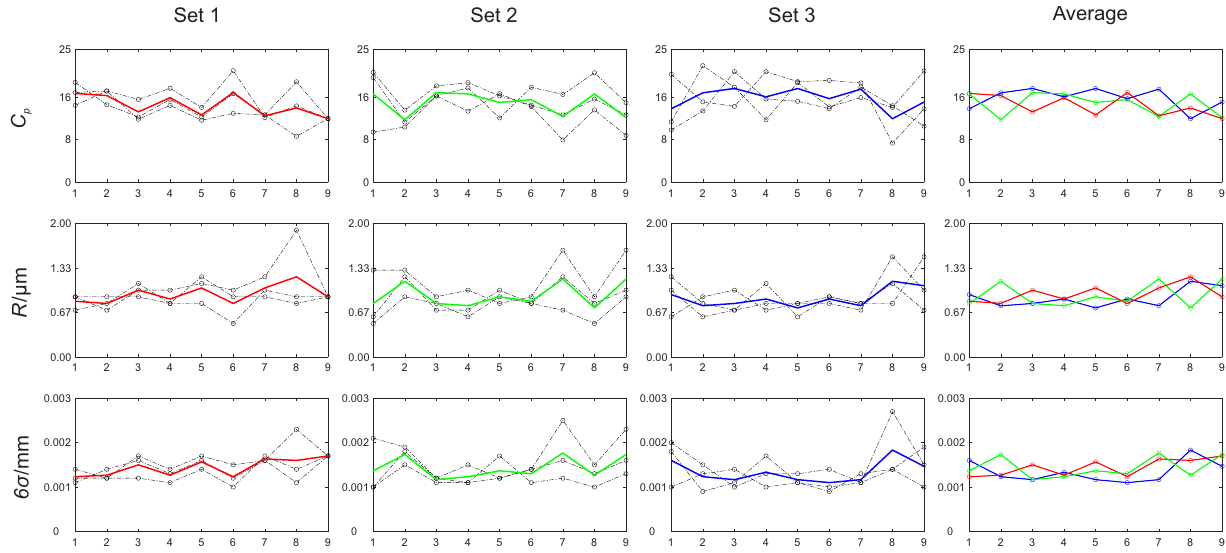
Figure 8. Measurement results for a Magnet object characteristic code 20 (diameter) for all measuring sets and the average. The red line represents the average of set 1, the green line represents the average of set 2, the blue line represents the average of set 3, and the black dotted lines represent individual repetitions of the desired set of measurements. The absolute value of statistical parameters ( C p , R , and 6 σ ) is not as significant as the decreasing/increasing trend. Scenario numbers appear on the horizontal